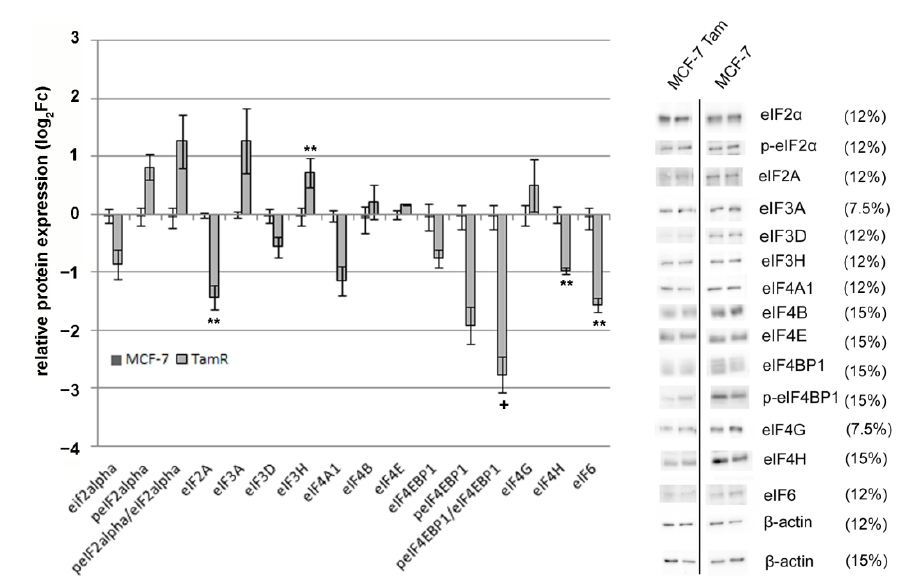
Figure 5. Abundance of eIF proteins in MCF-7-Tam compared to MCF-7-cells determined by Western blot. n = 3. Standard error is shown. The panel on the right shows the results of one representative experiment. The percentages refer to the density of the SDS-polyacrylamide gels used for Western blotting. Expression values (log 2 Fc), as well as statistical analysis, are shown in Supplemental Table S5. ** p < 0.01; * p < 0.5; + p < 0.1.